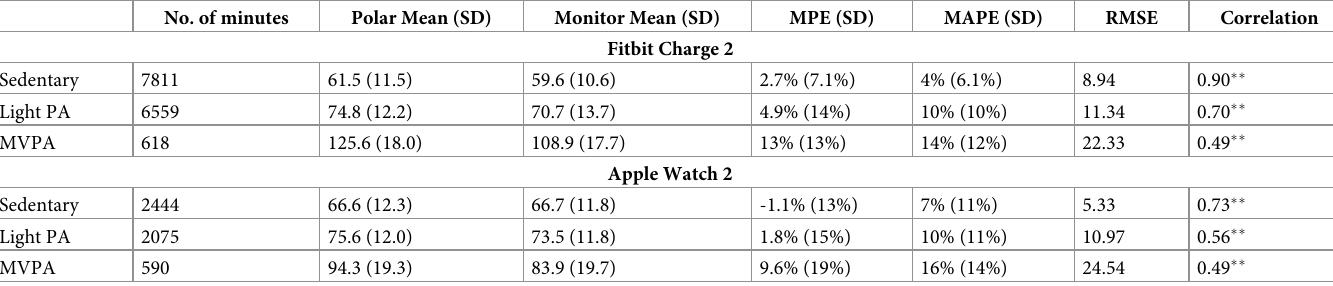
Table 3. Validity of heart rate estimation from Apple Watch 2 and Fitbit Charge 2.